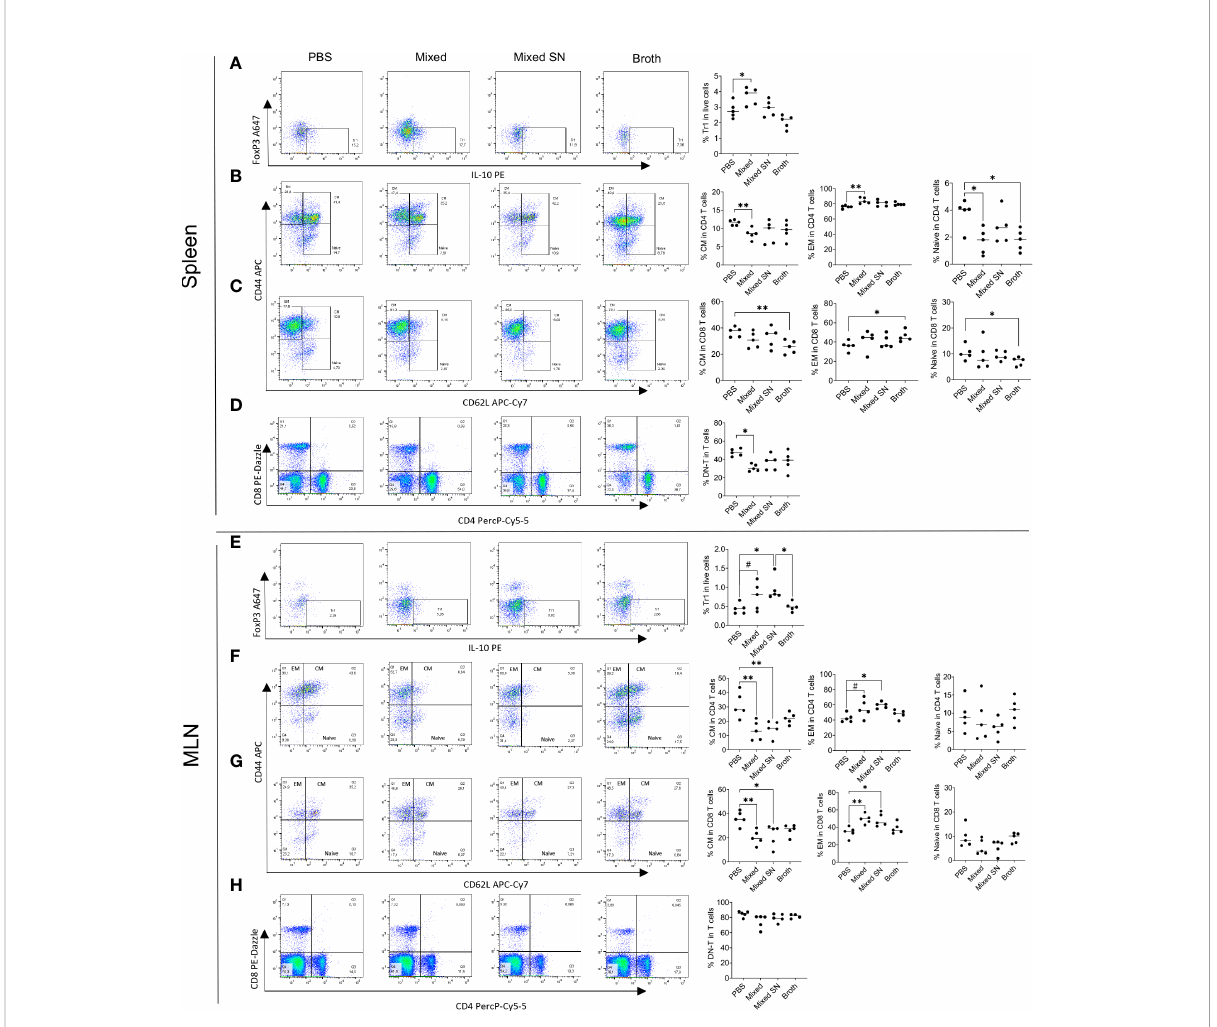
FIGURE 4 Lactobacillus spp. control in fl ammation through regulating splenic and MLN immune cell populations. (A – D) Flow cytometry analysis of splenocytes. (E – H) Flow cytometry analysis of MLN cells. (A – E) Frequency of IL-10-expressing type 1 regulatory T (Tr1) cells. Plots were pre- gated on CD4 + T cells. (B, F) Frequencies of central memory (CM) and effector memory (EM) T cells as well as naïve T cells within CD4 + T cells. Plots were pre-gated on CD4 + T cells. (C – G) Frequencies of CM and EM T cells as well as naïve T cells within CD8 + T cells. Plots were pre- gated on CD8 + T cells. (D – H) Frequency of double-negative T (DNT) cells. Plots were pre-gated on T cells. Statistical signi fi cance (* p <0.05, ** p <0.01) is shown based on one-way ANOVA. Nearly signi fi cant differences are shown as # p